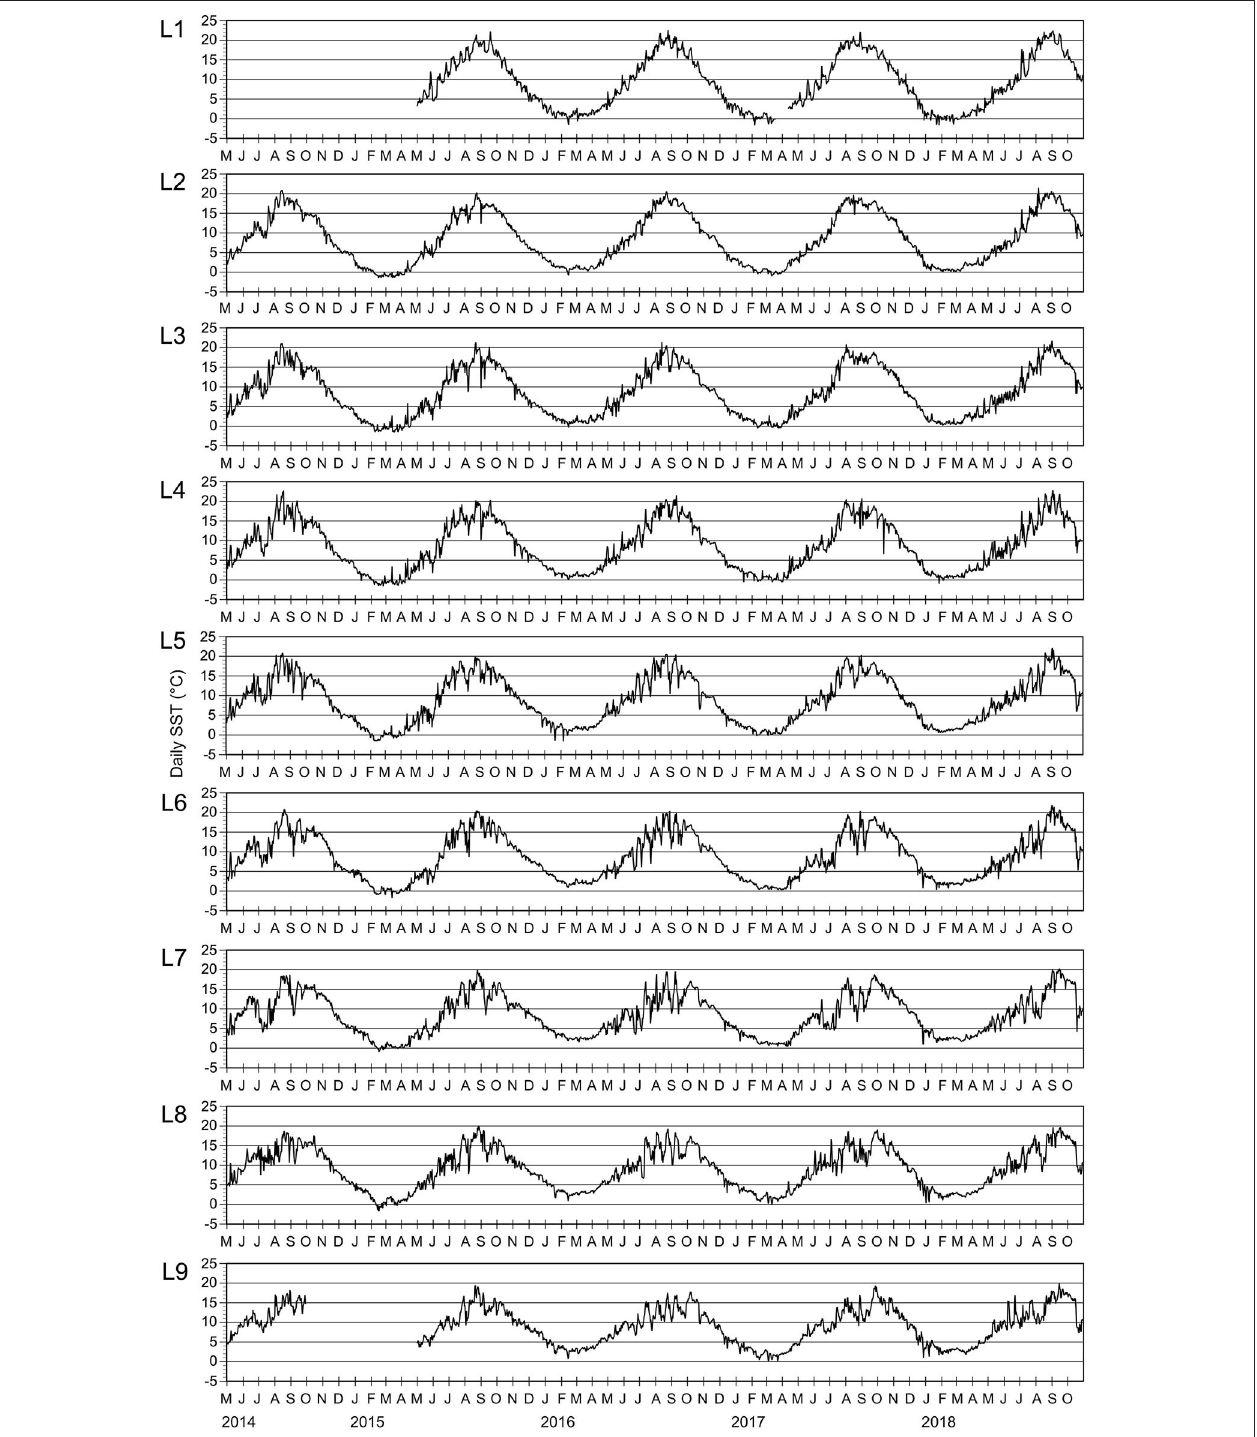
FIGURE 3 | Daily SST at the nine wave-exposed intertidal locations (L1–L9, from north to south) surveyed along the Atlantic coast of mainland Nova Scotia between 1 May 2014 and 31 October 2018 (with exceptions as noted in section Materials and Methods). Each monthly tick mark along the X axis is positioned on the first day of the